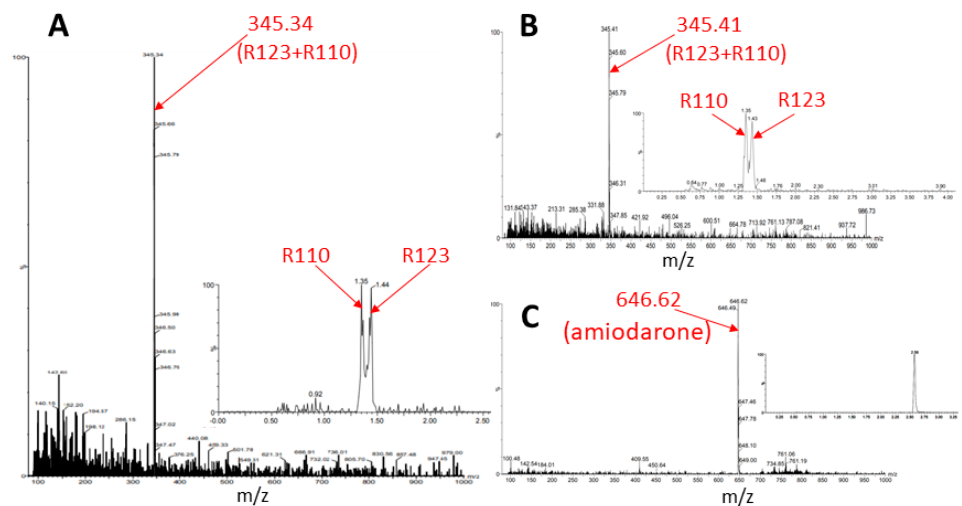
Figure 9. Mass spectrometry of butanol extracts of astroglial cells after cultivation with Rh123 (2 µM, ( A )) or together with amiodarone (2 µM, ( B , C )). In A, one major component is resolved apparently belonging to rhodamines 123 and 110 with mass/charge = 345.34 with retention times for Rh110 and 123, 1.35, and 1.44 correspondingly (inset). The incubation with amiodarone results in not many changes except the presence of amiodarone (inset).